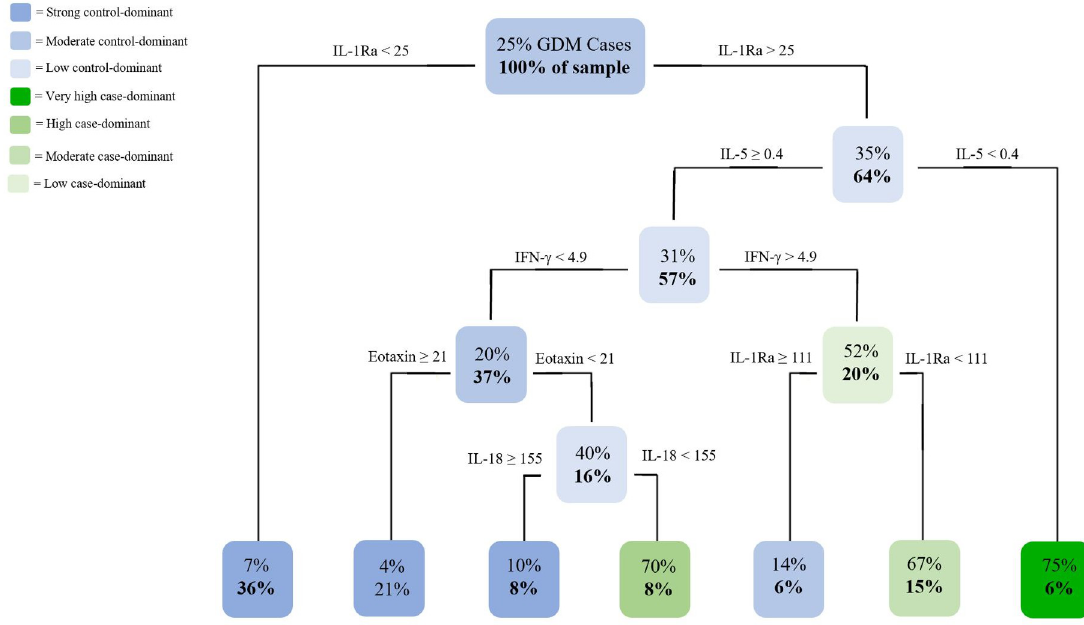
Fig 2. CART analysis of cytokine levels of participants within the GDM subset. Analysis of the GDM subset (n = 124) representing the probability of disorder diagnosis and percentage of the sample size using R software. Specific cytokines and cut-off levels (pg/mL) that are the most important in distinguishing cases versus controls were identified with colours and shading representing the likelihood of condition